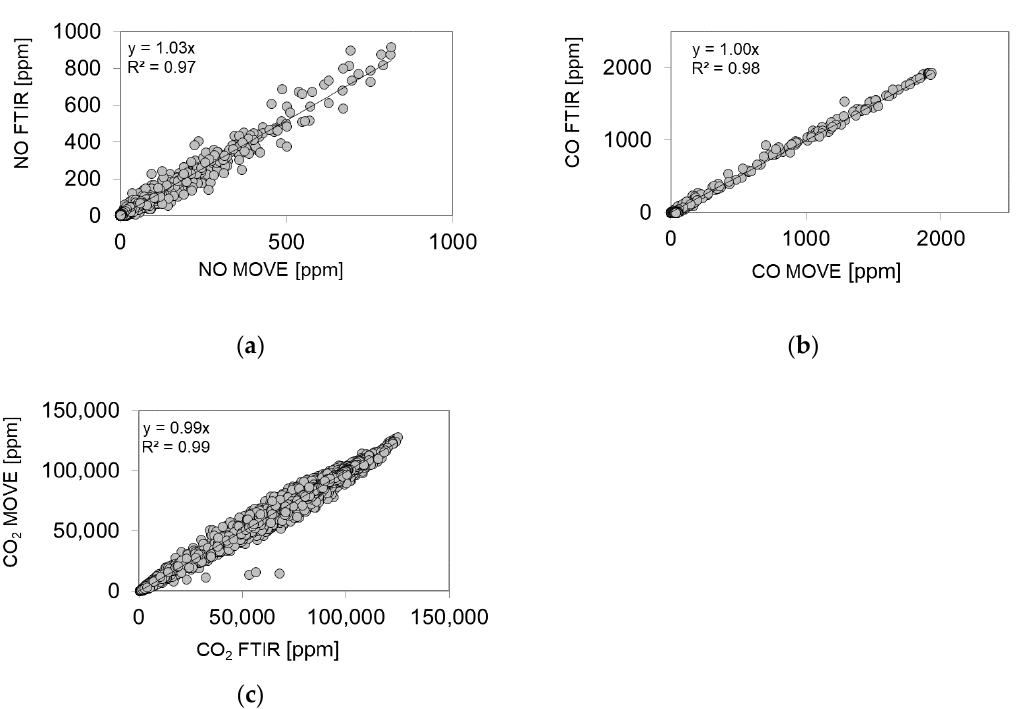
Figure 1. Correlation between the measurements of ( a ) NO, ( b ) CO, and ( c ) CO 2 carried out with the portable FTIR and the AVL MOVE PEMS during on-road testing of the DV1.